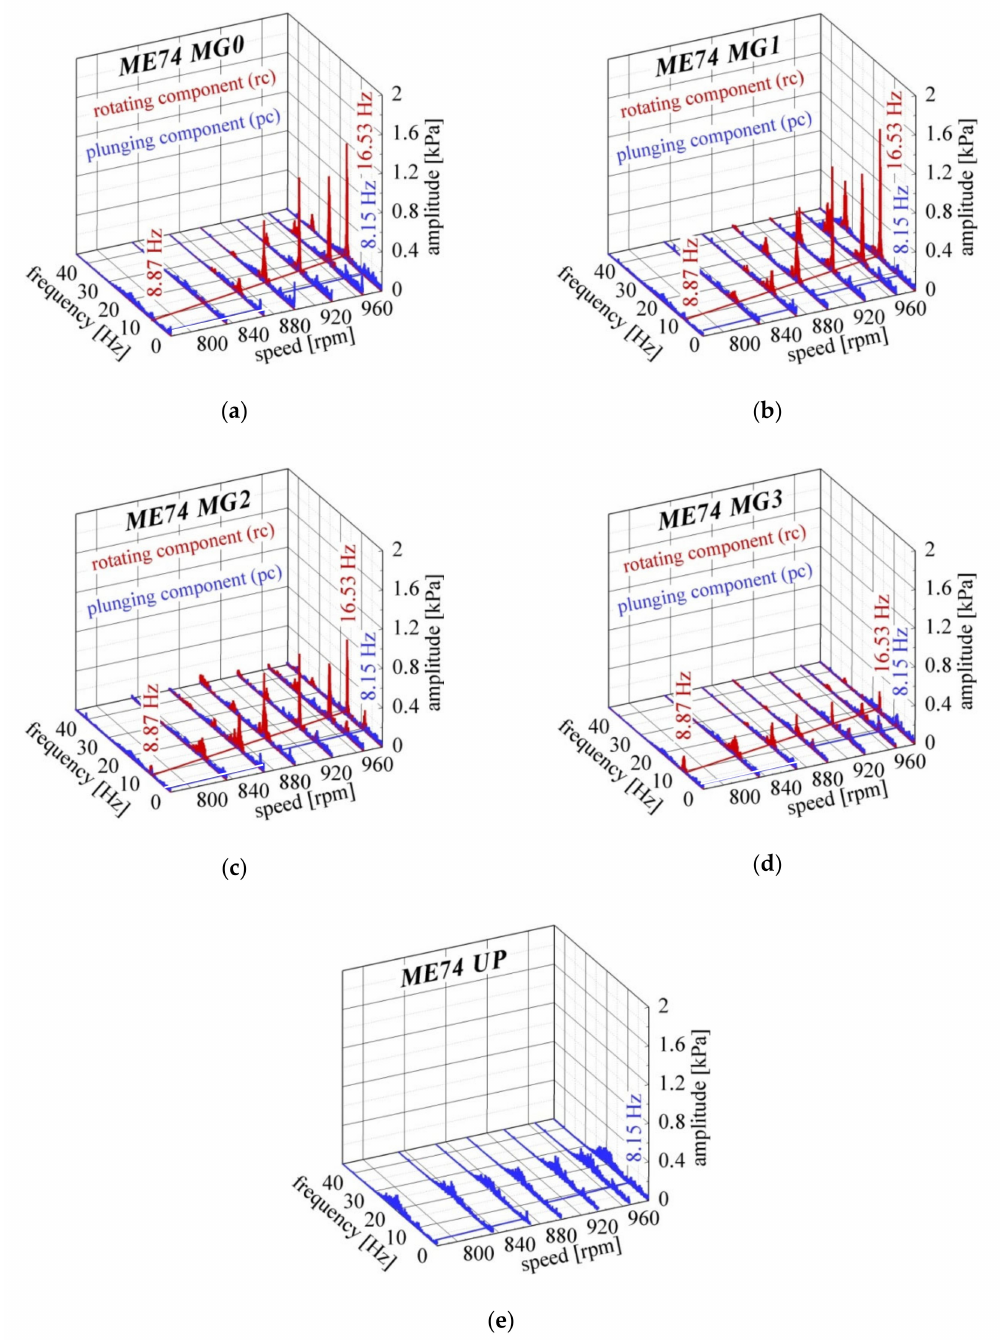
Figure 6. Three-dimensional waterfall diagrams of the decomposed power spectra of the pressure signals (plunging—blue and rotating—red) acquired on the test section levels with ME74 for variable operating conditions: ( a ) MG0, ( b ) MG1, ( c ) MG2, ( d ) MG3 and ( e )